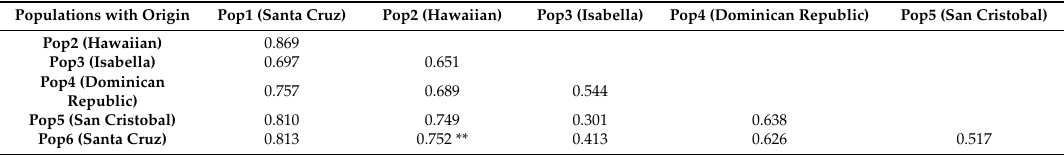
Table 3. Pairwise Fst estimates for the five groups corresponding to six regions of accession collections as identified by